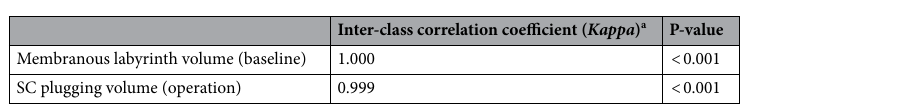
Figure 4. Individual 3D-based visualization of SC-plugging status using surface and direct volume rendering. The blue architecture indicates the volume difference between preoperative and postoperative data and represents the filling defect after surgical plugging. The images in this figure were created using a C++ and OpenGL-based program by our co-authors. Therefore, no external entity was used and no citation is required.